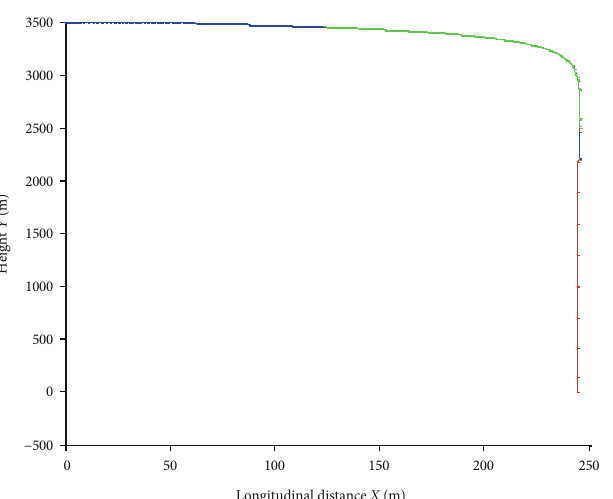
Figure 4: Longitudinal plane trajectory curve.